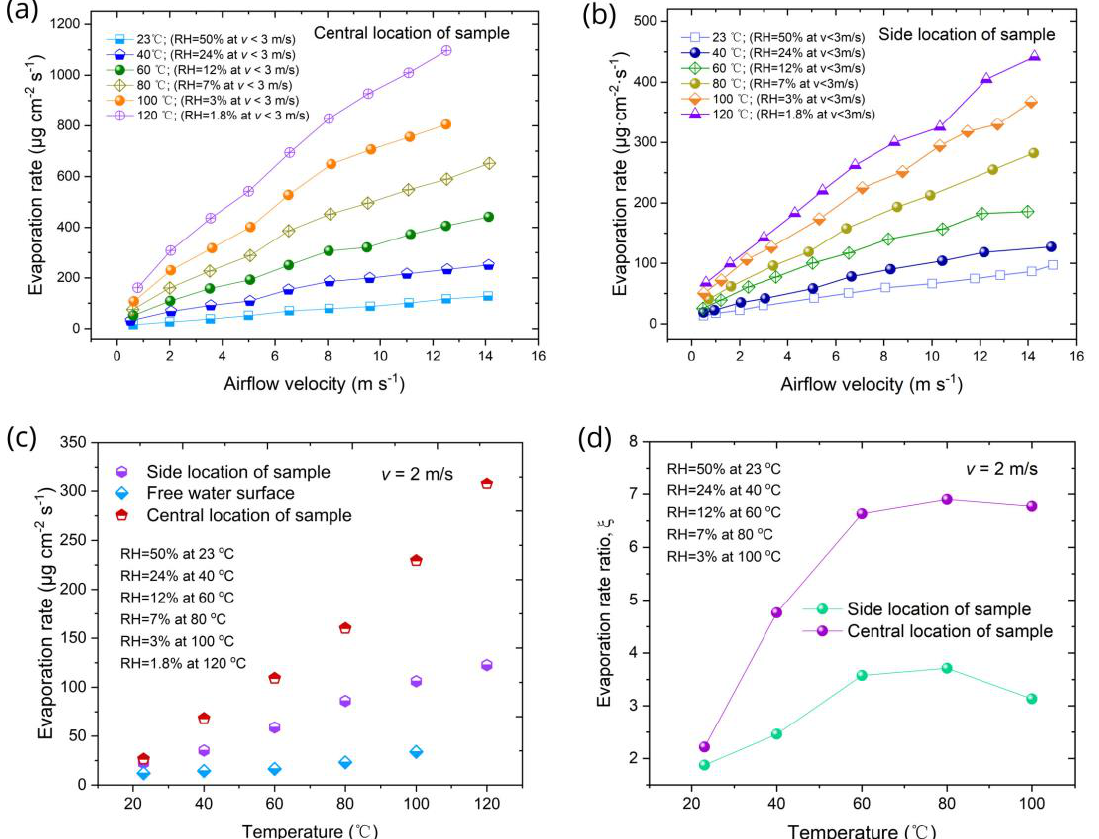
Figure 5. Wind tunnel experiments on wicking and evaporative functionalities under airflow con- ditions. ( a ) Evaporation rate R s of the sample as a function of airflow velocity at various airflow temperatures for central sample location. ( b ) Evaporation rate R s of the sample as a function of air- flow velocity at various airflow temperatures for side sample location. ( c ) Evaporation rates of the sample and surface of the water in a container as a function of temperature at airflow velocity of 2 m/s. ( d ) Evaporation rate ratio ξ = R s / R fs as a function of temperature at airflow velocity of 2 m/s.